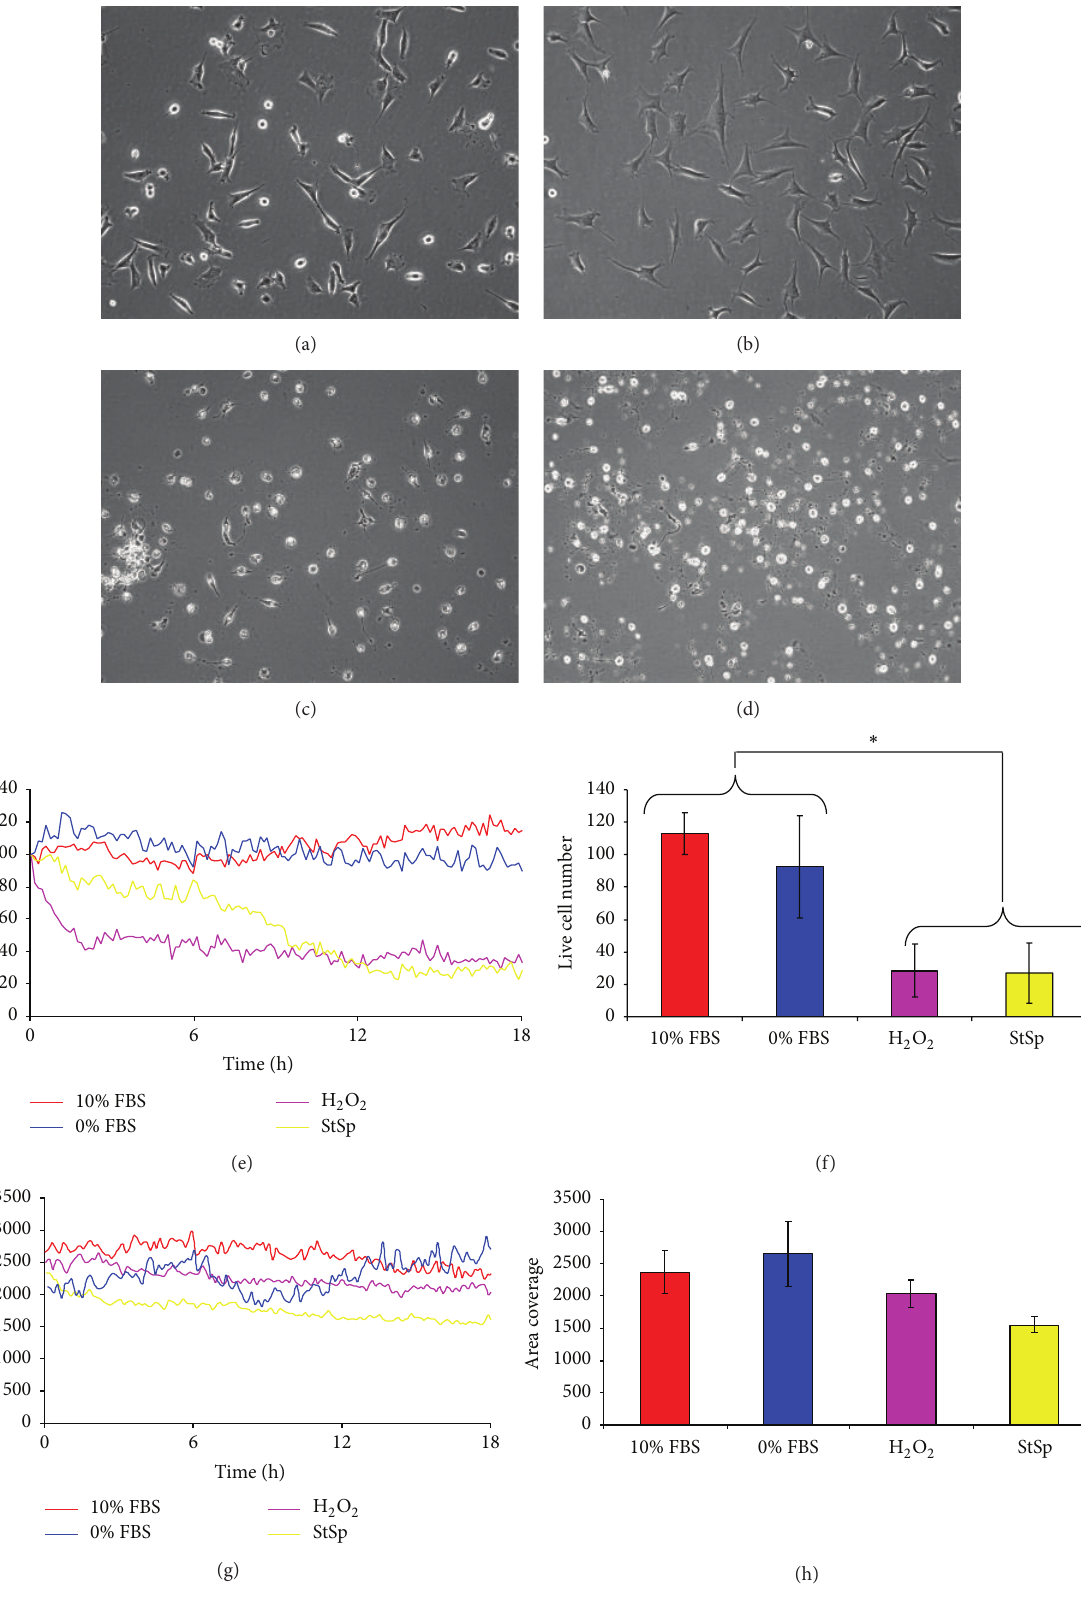
Figure 6: The response of bovine NP cells to induction of cell death inducers over 18 hours. Representative phase contrast images following 18-hour exposure to 10% (a) or 0% (b) FBS with moderate glucose, (c) hydrogen peroxide, and (d) staurosporine. (e) Temporal analysis for live cell number, expressed as percentage of the initial live cell number. (f) Live cell number, expressed as a percentage of the initial live cell number at the final time point ( ± SEM). (g) Temporal analysis for area coverage normalised to live cell number. (h) Area coverage, normalised to live cell number, at the final time point ( ±